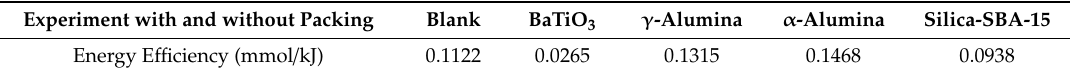
Table 4. The energy e ffi